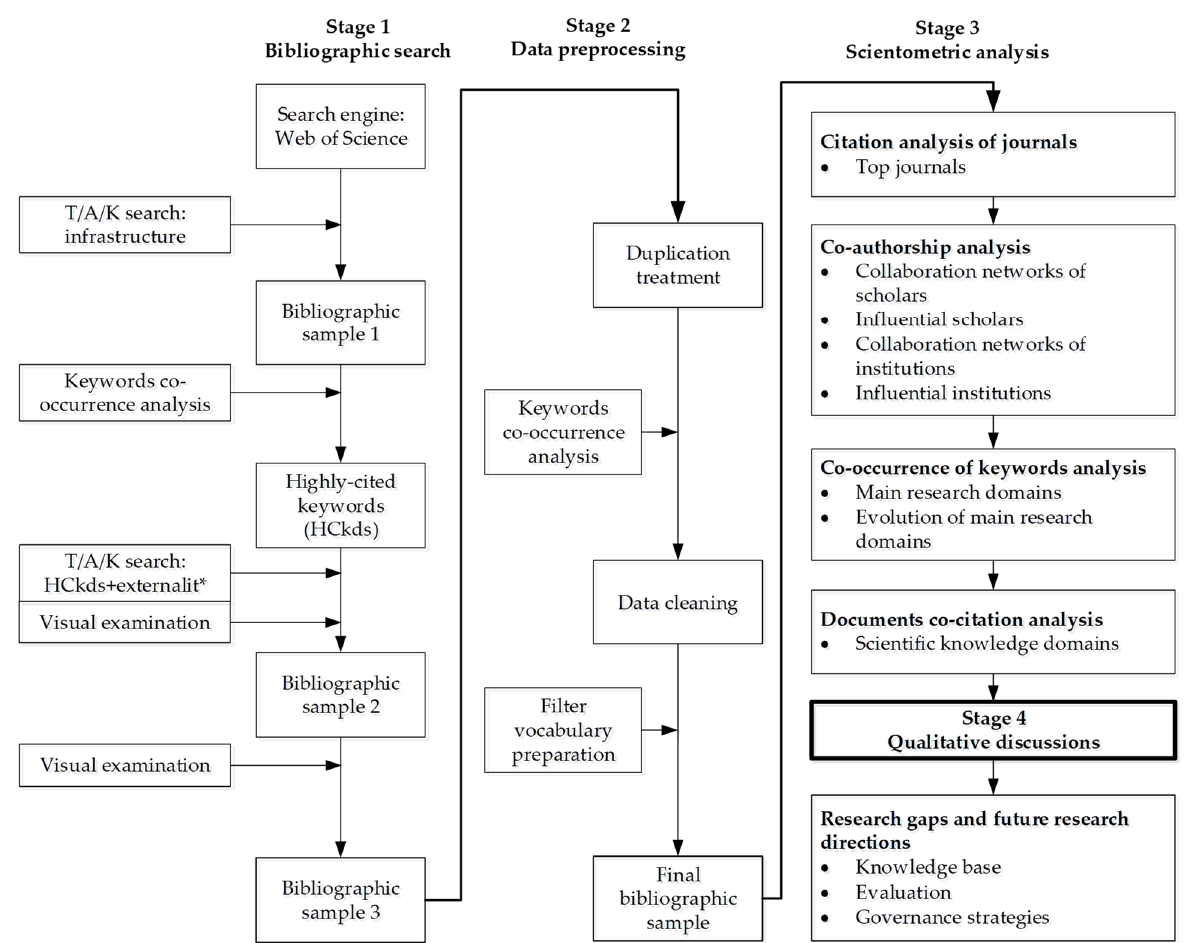
Figure 1. Flow chart of the four-stage literature review process.